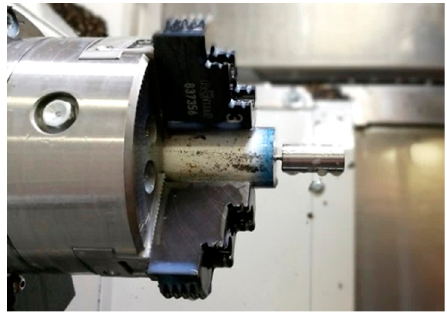
Figure 7. Production of cylinders for experimental testing.